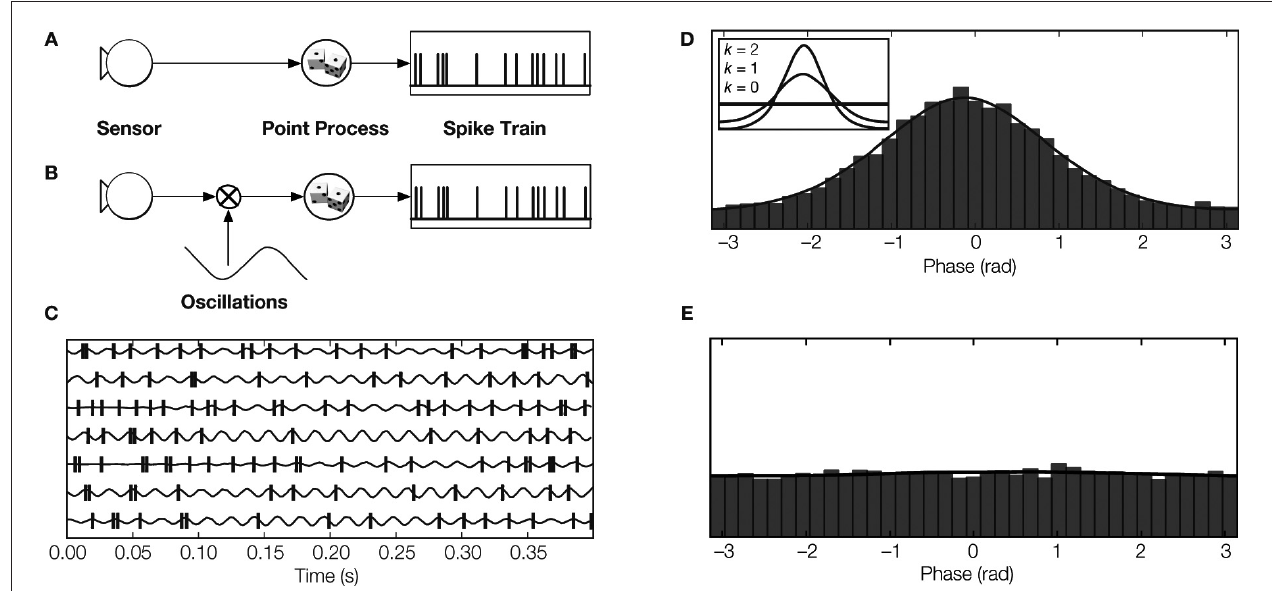
Figure 3 | Modeling spike trains of sensory neurons. (A) Conventional rate coding : The spike train is modeled by a point process with an instantaneous rate that is modulated by the magnitude of the stimulus feature (Kuffler et al., 1957; Perkel et al., 1967). (B) Multiplicative model : The spike rate is modeled by a point process that is modulated by the product of the value of the sensory feature and an independent oscillatory signal. Thus, the spike train contains information about sensory stimulus and about oscillation phase (Berman, 1981; Koepsell and